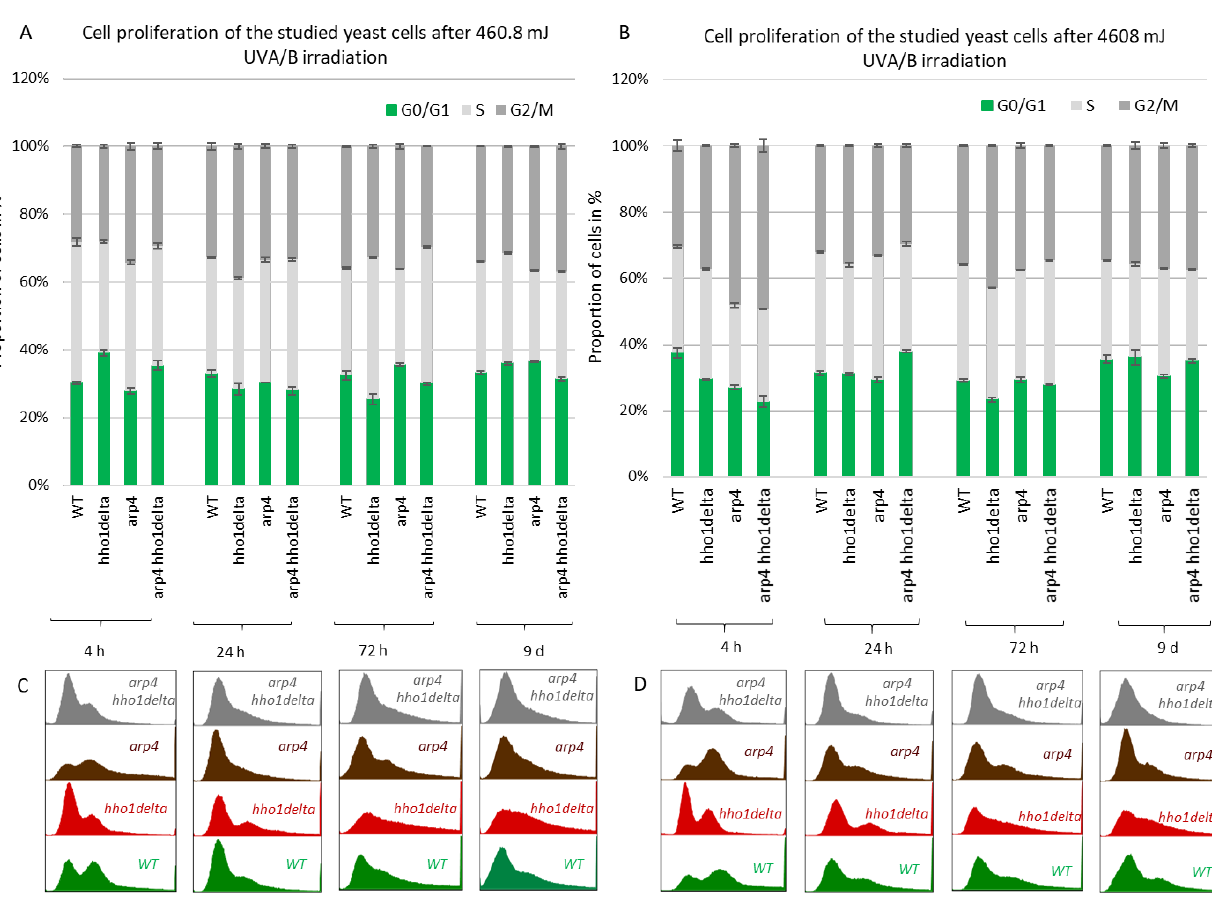
Figure 5. Cell cycle progression of WT, hho1delta , arp4 and arp4 hho1delta yeast strains cultures after UVA/B irradiation. ( A ) 3 min (460.8 mJ), ( B ) 30 min (4608 mJ) UVA/B irradiation with representative FACS cell cycle histograms ( C ) for 460.8 mJ and ( D ) for 4608 mJ. Three repetitions of the experiment are done and results are presented as a percentage of the cells of each strain at the given time point without irradiation with the respective STDVs. Each color represents the portion of cells in the cell cycle phase calculated from the non-irradiated sample.